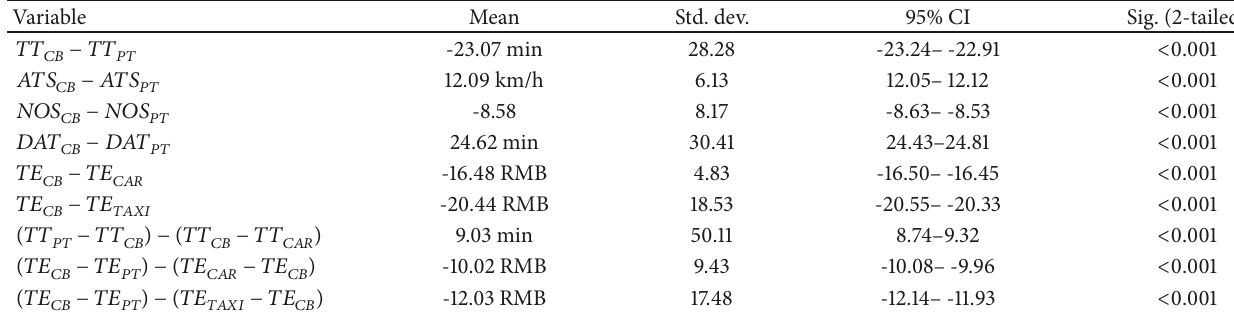
Table 3: Results of paired mean difference t-tests.